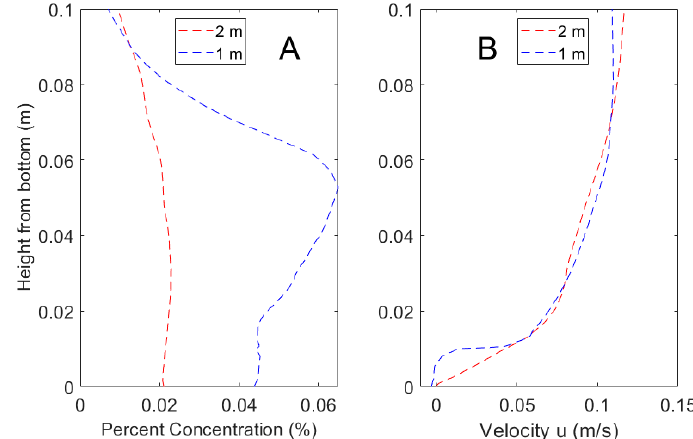
Figure 5. ( A ) Mean concentration as a percent of source concentration at 1 m and 2 m downstream from the odor source, measured along the plume centerline. ( B ) Mean horizontal velocity at 1 m and 2 m downstream from the odor source.